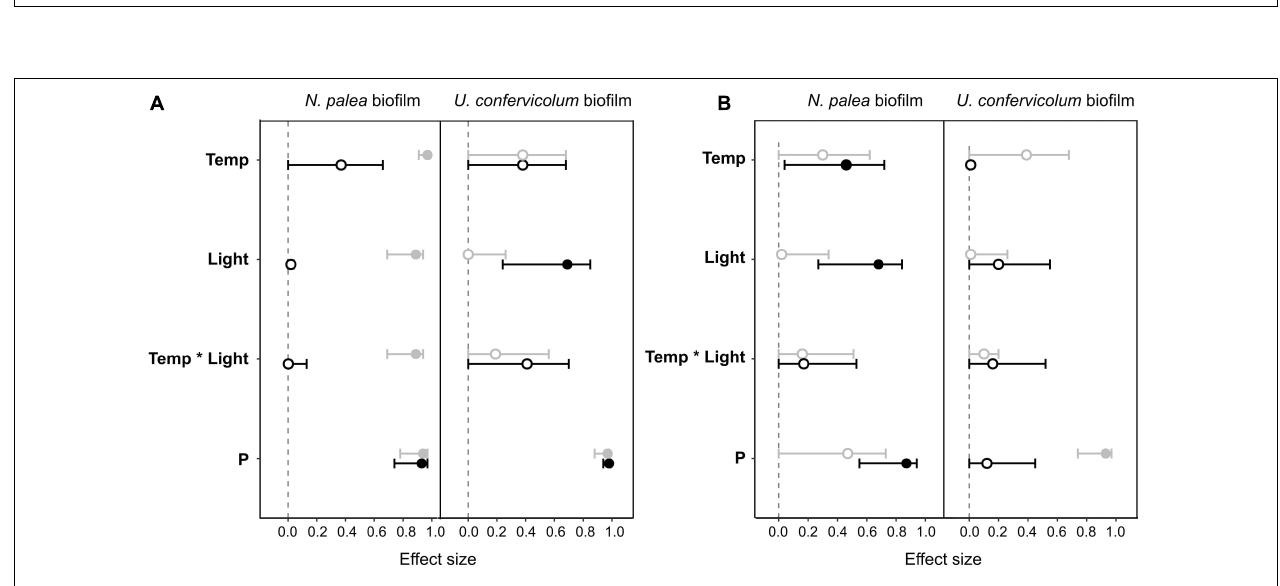
FIGURE 6 | Effect size (partial eta-squared ± 95% confidence interval) on the impact (gray circles) or recovery (black circles) of the total organic carbon (A) and the protein/polysaccharide ratio (B) for the N. palea biofilm and U. confervicolum biofilm for the environmental factors tested: temperature (Temp), light intensity (Light), phosphorous concentration (P). The temperature ∗ light intensity interaction is also given. Closed circles: significant effects, open circles: non-significant effects.